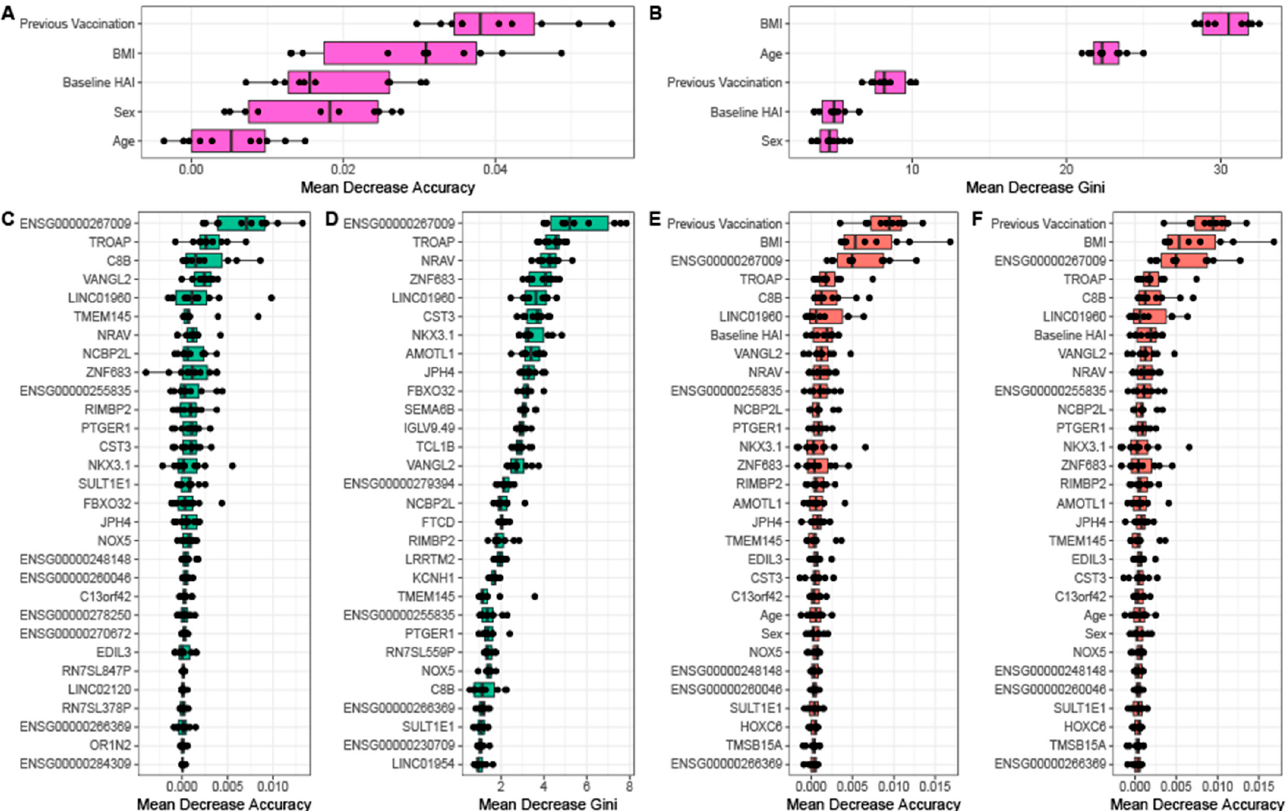
Figure 6. Identification of factors underlying random forest model performance. Variable importance measured through mean decrease accuracy and mean decrease in Gini coefficient for random forest models generated using participant ( A , B ) physiological metrics, ( C , D ) the 84 DEGs as a function of exclusively seroconversion, and ( E , F ) physiological metrics and the 84 DEGs combined.